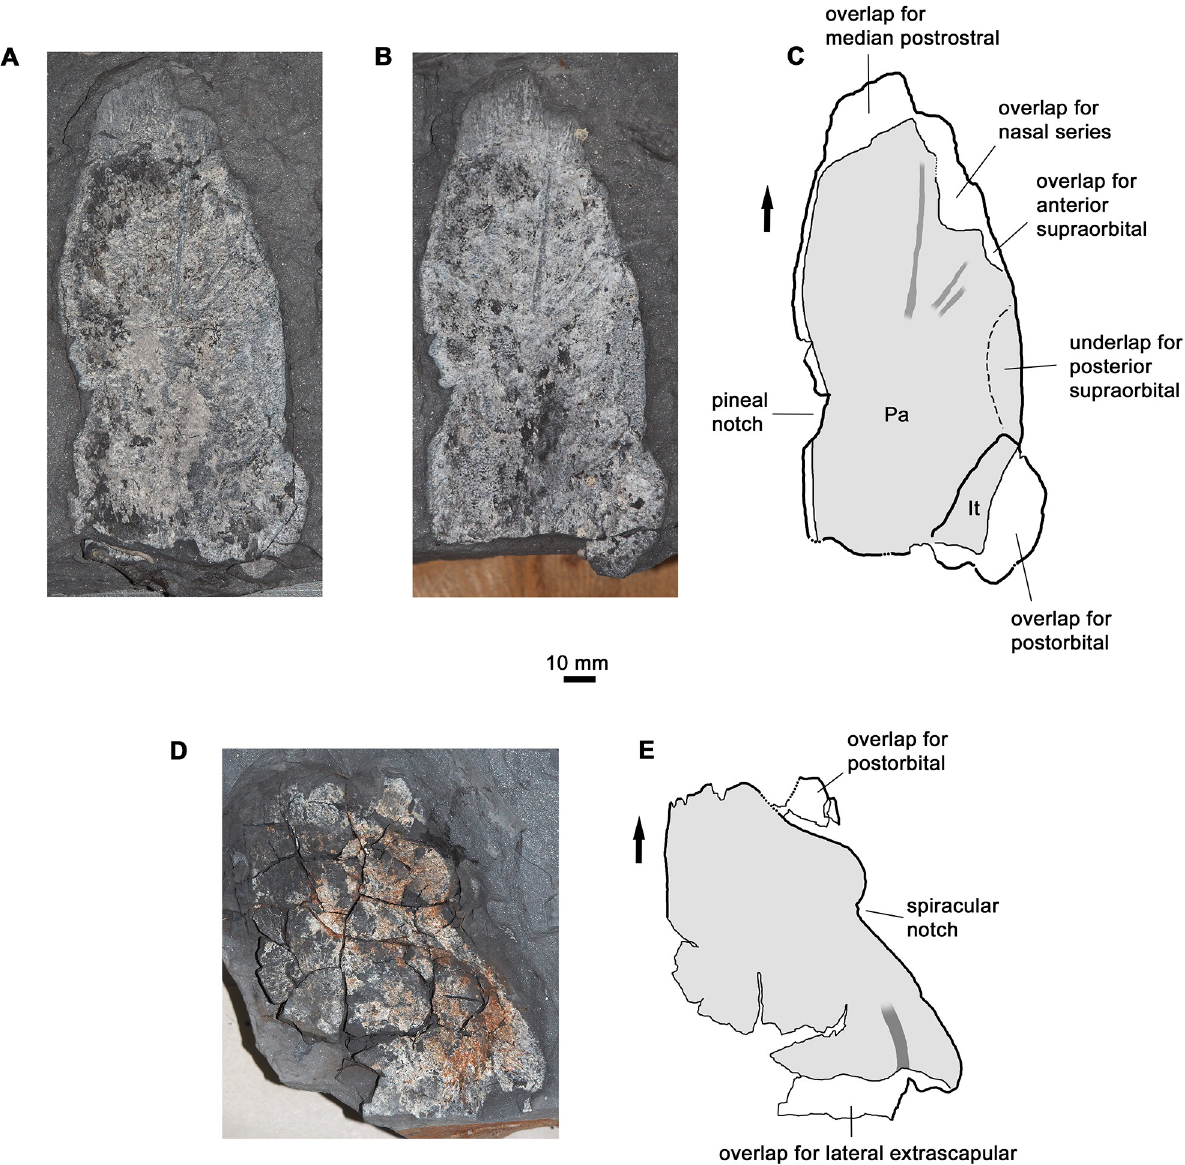
Fig 4. Skull roof bones. A-B, specimen photographs of parietal plus intertemporal, AM6535c,d, in part and counterpart (left-right reversed) view. C, interpretative drawing combining information from A and B. D, specimen photograph of postparietal-supratemporal-tabular (sutures not visible), AM6540a. E, interpretation of D. Thick outline denotes true margin; dotted thick outline, inferred true margin; thin outline, broken margin or edge of ornamented external surface; pale grey, ornamented external surface; dark grey, lateral line canal; black arrow, anterior. Abbreviations as in Fig 3. Specimens are shown to the same scale but the parietal represents a larger